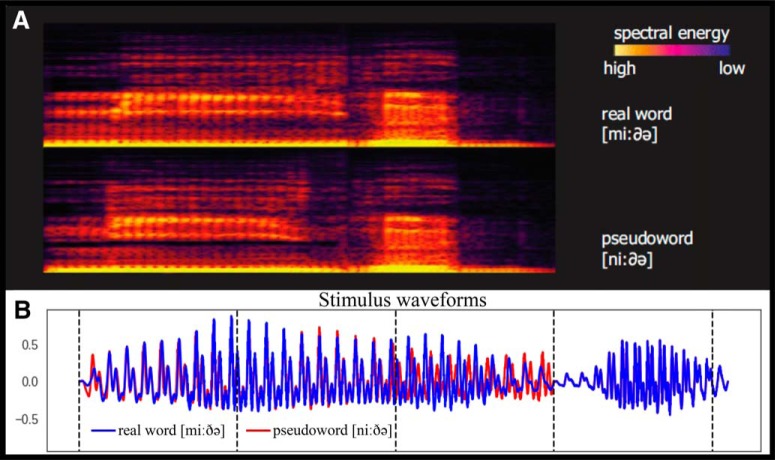

A, Examples of spectrograms of spoken stimuli used in the experiment (adapted from Gansonre et al., (2018)). B, Examples of waveforms plotted on top of each other.